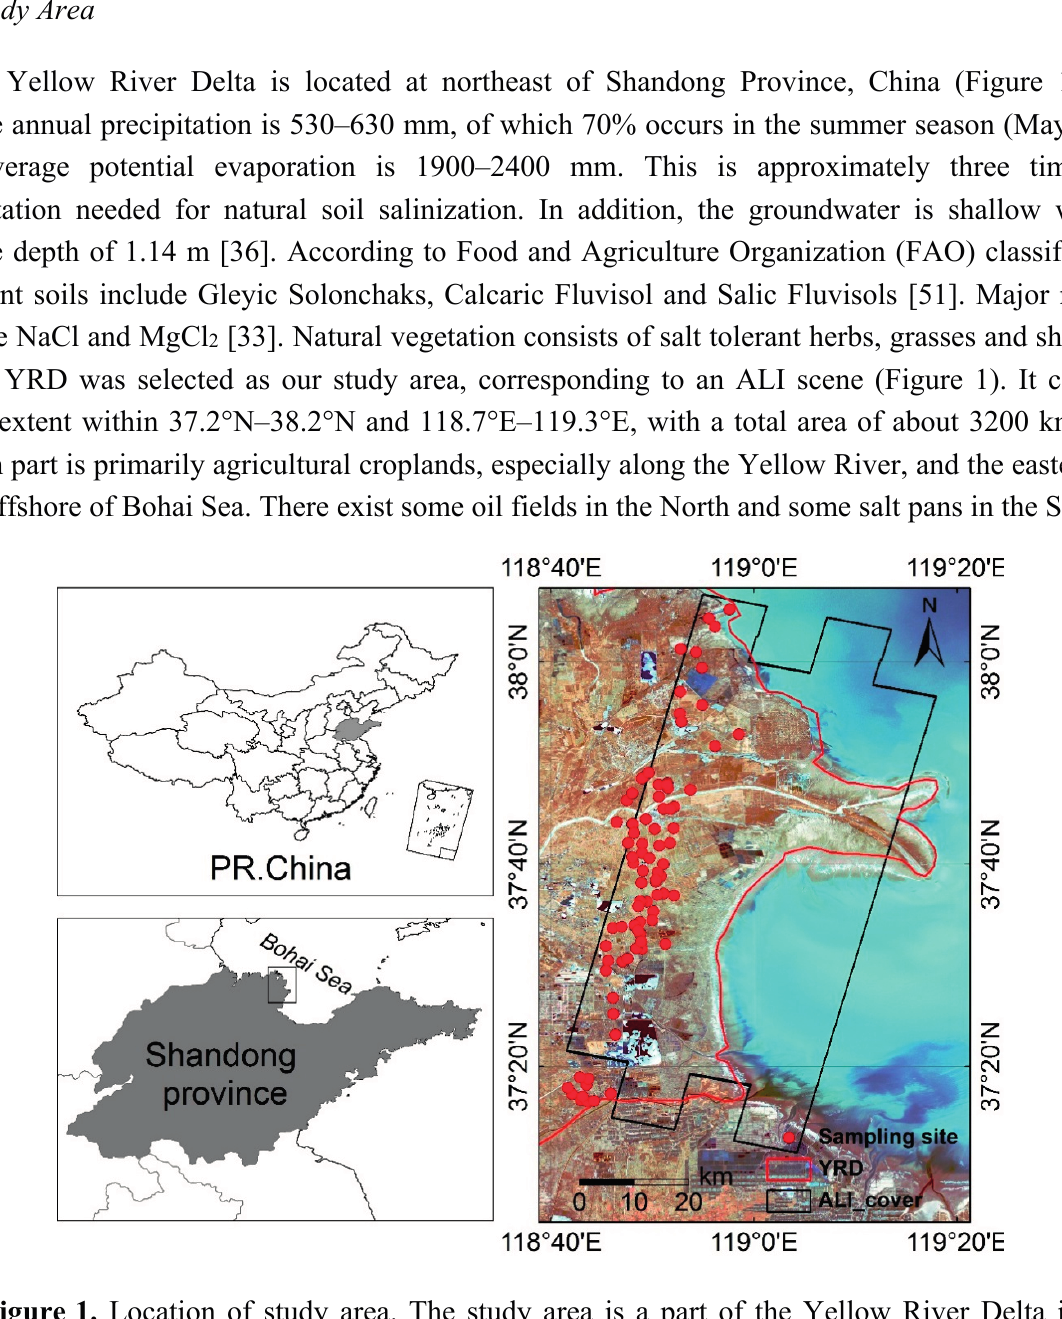
Figure 1. Location of study area. The study area is a part of the Yellow River Delta in Shandong province, China. The black frame confines our target area for soil salinity retrieval, corresponding to an ALI scene. The red line delineates the boundary of the Delta, and the red solid circles denote sampling